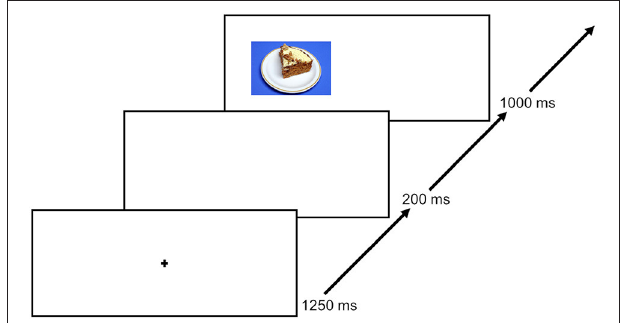
FIGURE 2 | An exemplary trial course. Each trial starts with a 1,250ms lasting fixation, followed by a 250ms ISI and thereafter a presentation of a food picture for 1,000ms. Only food stimuli were used. The next trial starts again with the fixation. The figure was previously published by Max et al.